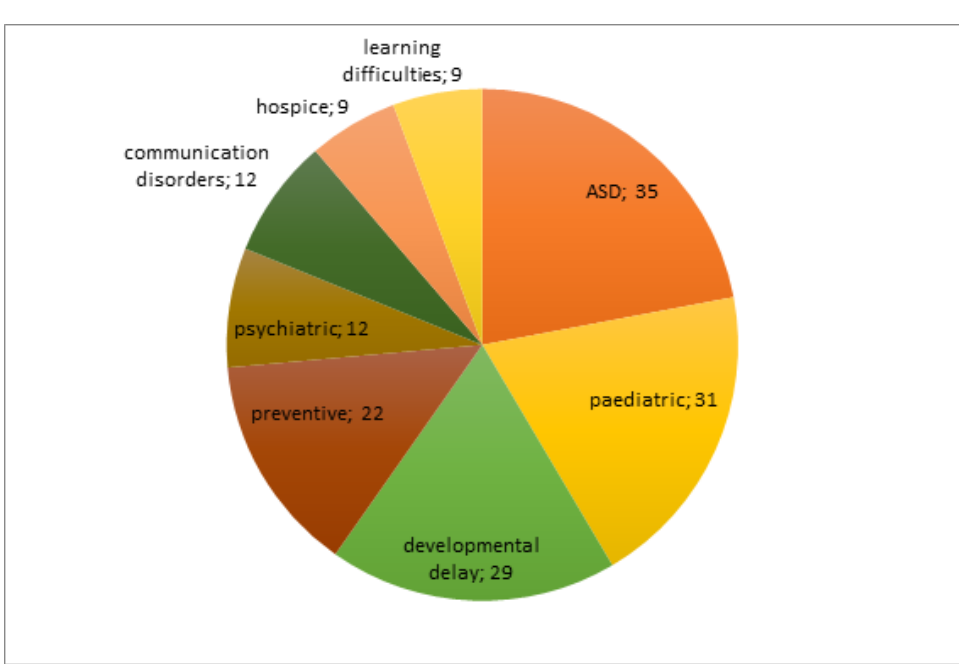
FFigigururee 8.8. CClientlient